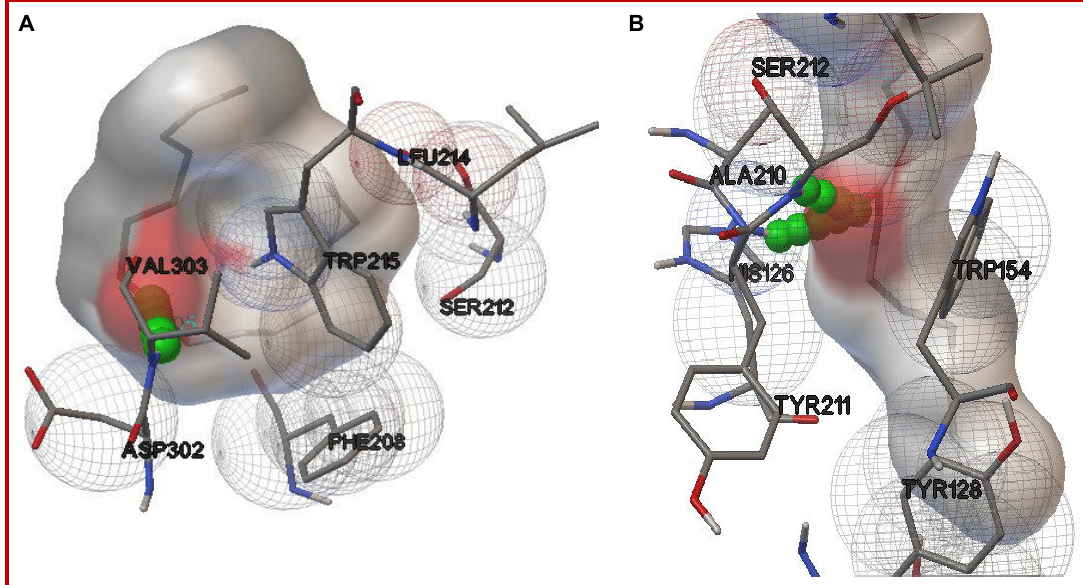
Figure 7: Inhibitory action of caprylone with DPP-IV using AutoDoc hydrogen bond interaction A) A chain B) B chain